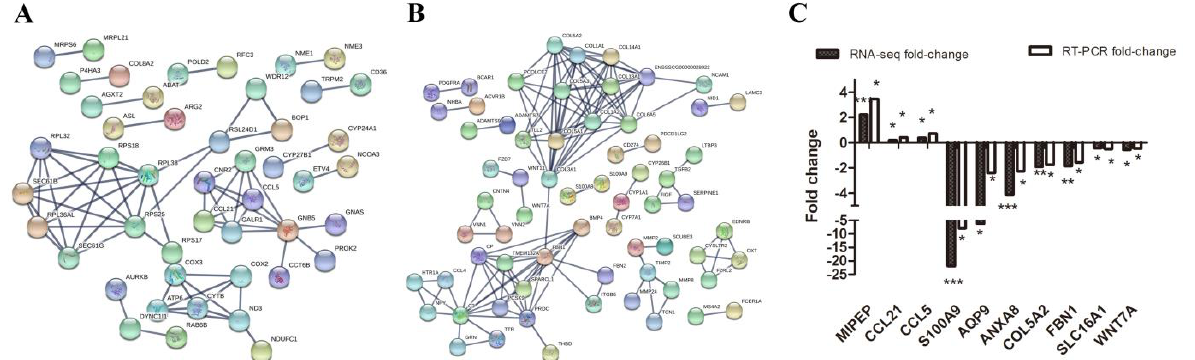
Figure 6. Protein–protein interaction analysis of up-regulated ( A ) and down-regulated ( B ) genes in the endometrium during embryo implantation in the HS treatment group and the control group. ( C ) Validation of the RNA-seq results by qRT-PCR. The data are presented as the means ± standard deviation (SD). * p < 0.05; ** p < 0.01; and *** p < 0.001.